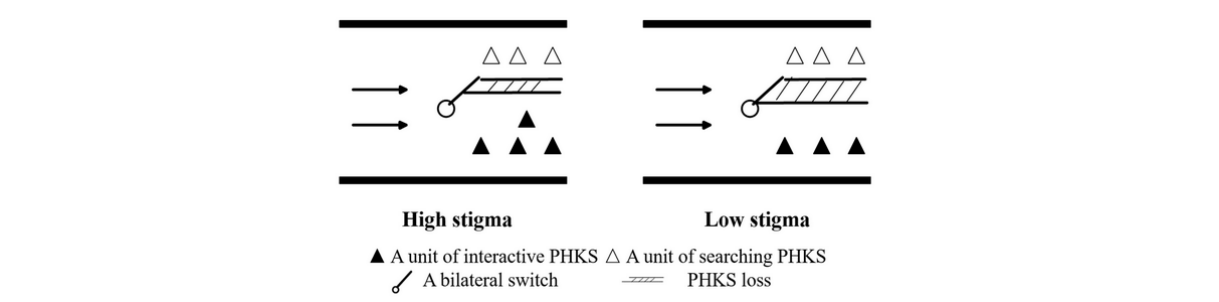
Figure 3. Illustration of the effect of disease stigma on interactive and searching professional health care knowledge sharing. PHKS: professional health care knowledge